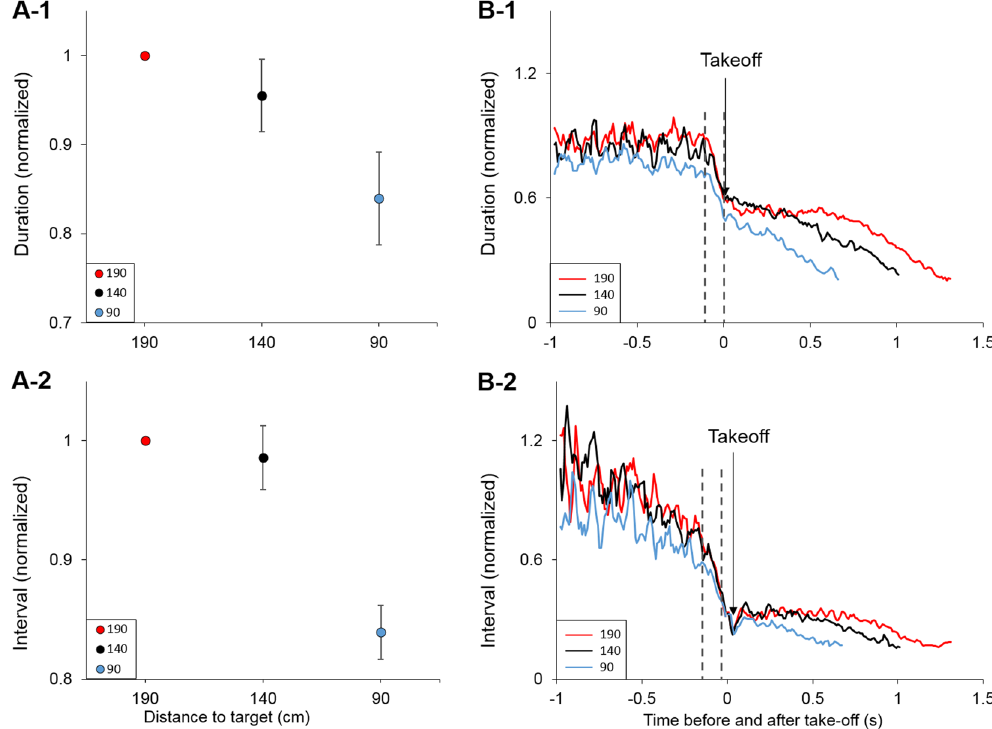
Figure 2. Bats assess distance to target before takeoff. ( A ) Echolocation signal duration (A-1) and interval between signal groups (A-2) are significantly shorter immediately before takeoff when the target is closer. Individual one-way ANOVA followed by Tukey’s post-hoc were performed for each individual for which values distribution was normal. For individuals whose values’ distribution was not normal we performed Kruskal- Wallis ANOVA on ranks followed by Dunn’s post-hoc. In all cases differences were significant between 190 cm and 90 cm. 140 cm was not always significantly different from both 90 and 190. For duration : Bat 1: H = 19.29, df = 2, P < 0.001 ( N = 96[190 cm], 15[140 cm], 40[90 cm]). Bat 2: F = 6.77, df = 2, P = 0.002 ( N = 19[190 cm], 32[140 cm], 32[90 cm]). Bat 3: F = 23.21, df = 2, P < 0.001 ( N = 42[190 cm], 23[140 cm], 22[90 cm]). Bat 4: F = 14.75, df = 2, P < 0.001 ( N = 118[190 cm], 65[140 cm], 76[90 cm]). For intervals : Bat 1: F = 4.44, df = 2, P = 0.017 ( N = 12[190 cm], 6[140 cm], 34[90 cm]). Bat 2: H = 7.94, df = 2, P = 0.019 ( N = 10[190 cm], 19[140 cm], 22[90 cm]). Bat 3: F = 7.04, df = 2, P = 0.03 ( N = 18[190 cm], 11[140 cm], 12[90 cm]). Bat 4: H = 6.41, df = 2, P = 0.041 ( N = 44[190 cm], 29[140 cm], 35[90 cm]). Statistical analyses were performed on raw individual data. Data were normalized for presentation (due to the differences in absolute individual values). We normalized by dividing each bat’s data by its 190 mean value (thus giving the mean at 190 an absolute value of 1 without variation, hence – no error bars). Data shown are the mean ± se for all bats. ( B ) Signal duration and intervals between signal groups as a function of time before and after takeoff (time point ‘0’). Longer signals and intervals are evident before takeoff and were probably used to assess the distance. Gray dashed lines mark the location in the sequence of the values shown in panels A-1 and 2. At takeoff there was a dramatic drop in these parameters. The mean of all bats is shown. See also Supplementary Figs S3 and